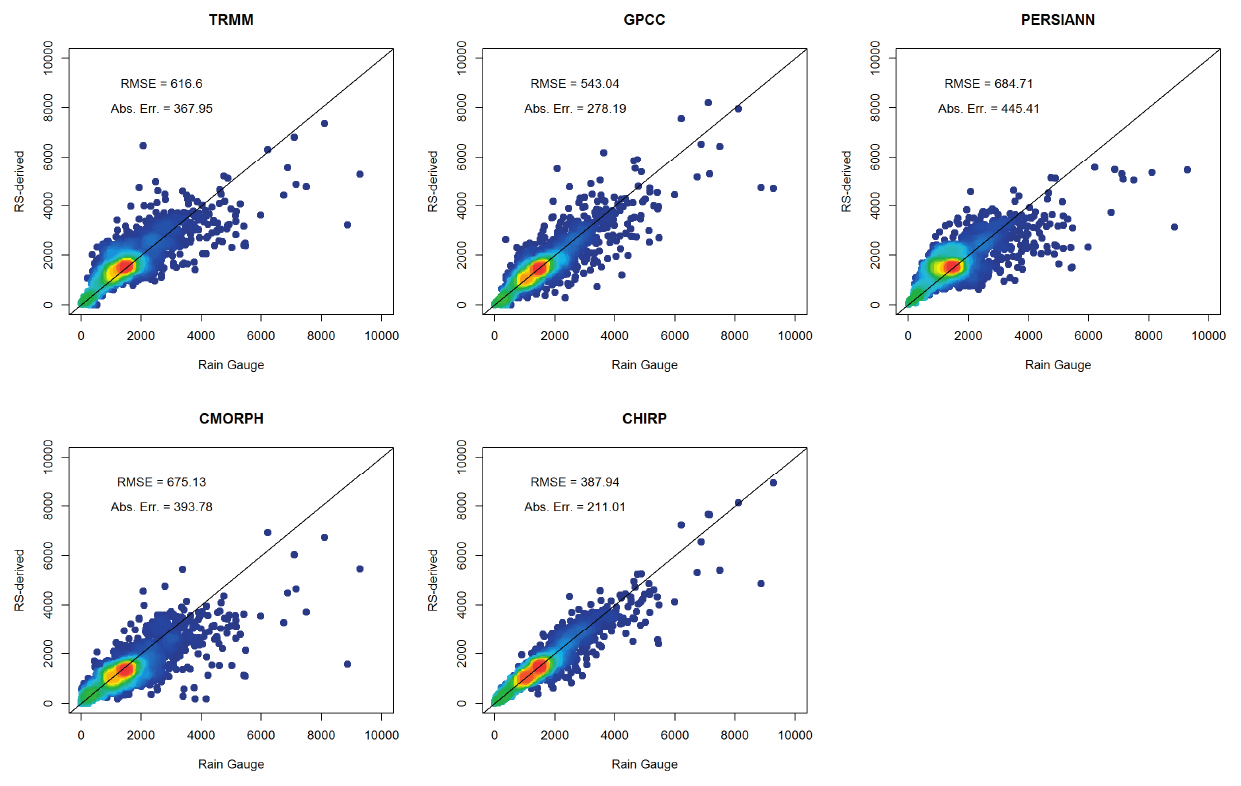
Figure 7. Scatterplot of Rain gauges versus Satellite-derived (RS-derived) precipitation for the entire South America. Reddish (bluish) areas in the plots indicate a higher (lower) density of sample